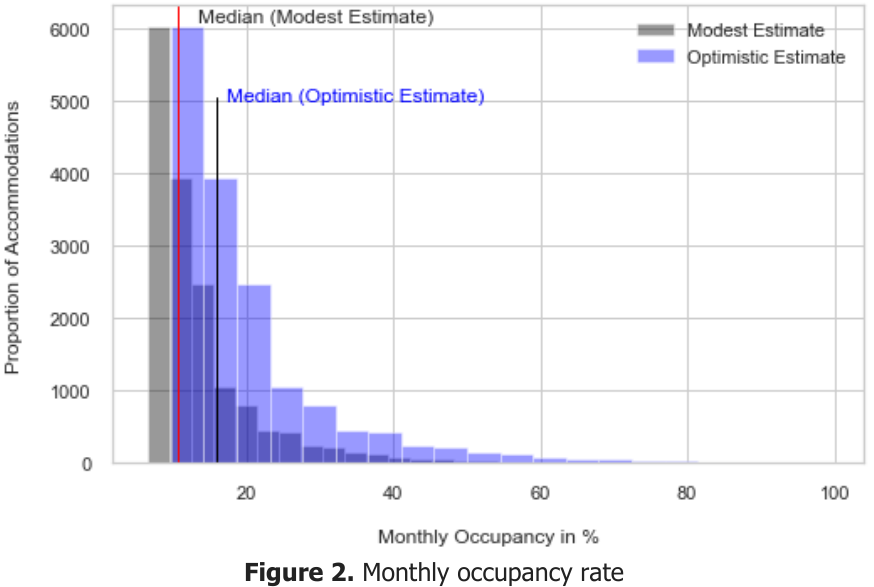
Figure 2. Monthly occupancy rate Table 1. Distribution of Modest and Optimistic Occupancy Estimate Modest Estimate Optimistic Estimate